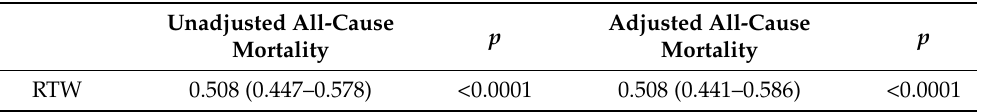
Table 2. Uni- and multivariate analysis of RTW and all-cause mortality in Cox proportional hazards